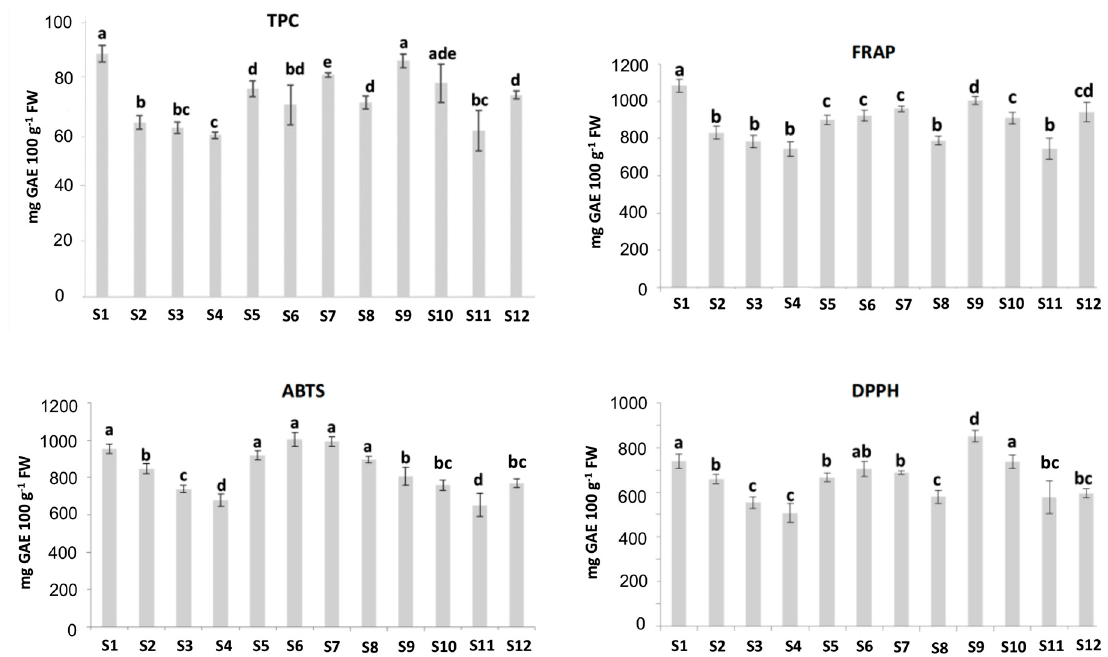
Figure 2. Total polyphenol content (TPC) (mg gallic acid equivalents (GAE) 100 g − 1 FW), 2,2-azinobis (3-ethylbenzothiazoline-6-sulfonic acid) diammonium salt (ABTS), ferric-reducing antioxidant power (FRAP) and 2,2-diphenyl-1-picrylhydrazyl (DPPH) (µmol Trolox 100 g − 1 FW) measurements for different raspberry cultivars from different origins; FW: Fresh weight. Results are expressed as mean ± standard deviation of three replicates for each sample ( n = 3). Different letters (a,b,c,d,e) represent statistically significant differences ( p < 0.05).